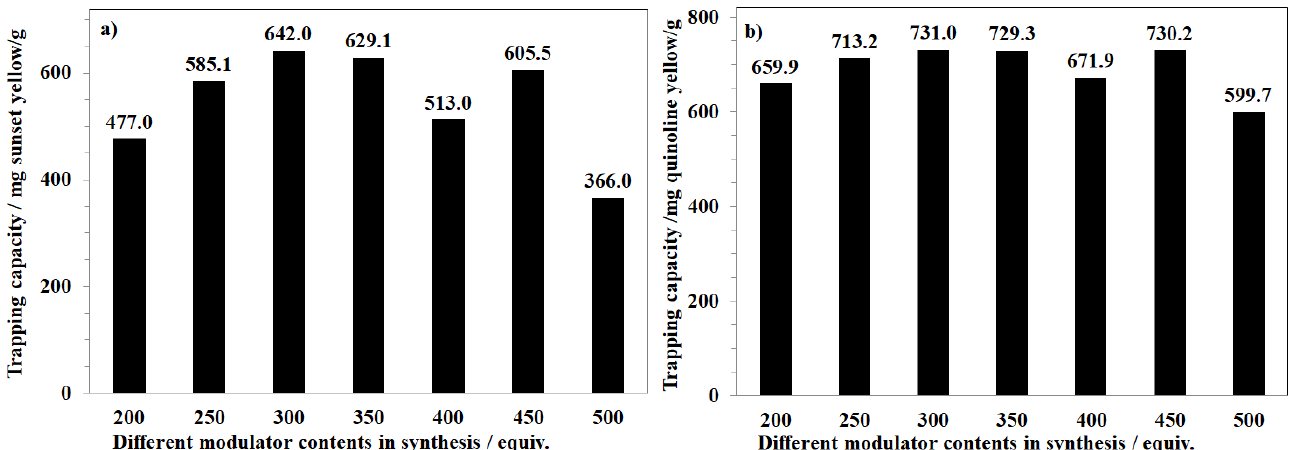
Figure 12. Sunset yellow ( a ) and quinoline yellow ( b ) trapping capacity of different MOF-808 samples synthesized with various formic acid concentrations in the synthesis phase.